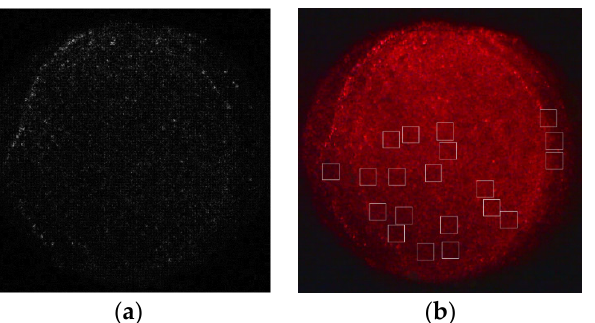
Figure 2. ( a ) Porous silicon image calculated by the eight-direction Laplacian; ( b ) a total of 20 homogeneous samples were selected.